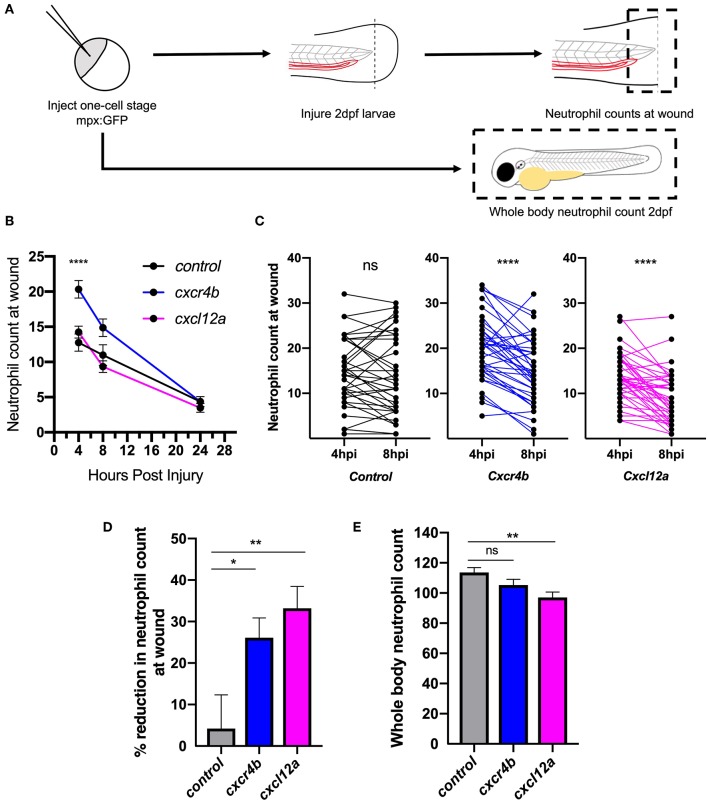
Knockdown of cxcr4b using CRISPR/Cas9 accelerates inflammation resolution. (A) Experimental schematic of CRISPR/Cas9 experiments in 2dpf mpx:GFP larvae. (B–D) CRISPR/Cas9-mediated knockdown of cxcr4b and cxcl12a accelerates inflammation resolution. (B) Time course of neutrophils at the wound site in control tyr crispant larvae (black line), cxcr4b crispant larvae (blue line), and cxcl12a crispant larvae (pink line) at 4, 8, and 24 hpi. Error bars shown are mean ± SEM. Groups were analyzed using an ordinary one-way ANOVA and adjusted using Tukey's multi comparison test. ****p < 0.001 n = 36 from 3 independent experiments. (C) Neutrophils at the wound site in individual larvae (black dots) at 4 and 8 h post injury in tyr crispant larvae (black), cxcr4b crispant larvae (blue), and cxcl12a crispant larvae (pink). Groups were analyzed using a paired t-test. ****p < 0.001 n = 36 from 3 independent experiments. (D) Resolution of the neutrophil component of inflammation was calculated between 4 and 8 hpi. Groups were analyzed using an ordinary one-way ANOVA and adjusted using Tukey's multi comparison test. *p < 0.04, **p < 0.004. (E) Whole body neutrophil numbers were measured in mpx:GFP crispant larvae at 2 dpf. n = 30–35 per group from 3 independent experiments. Error bars shown are mean ± SEM. Groups were analyzed using an ordinary one-way ANOVA and adjusted using Tukey's multi comparison test, **p < 0.005.